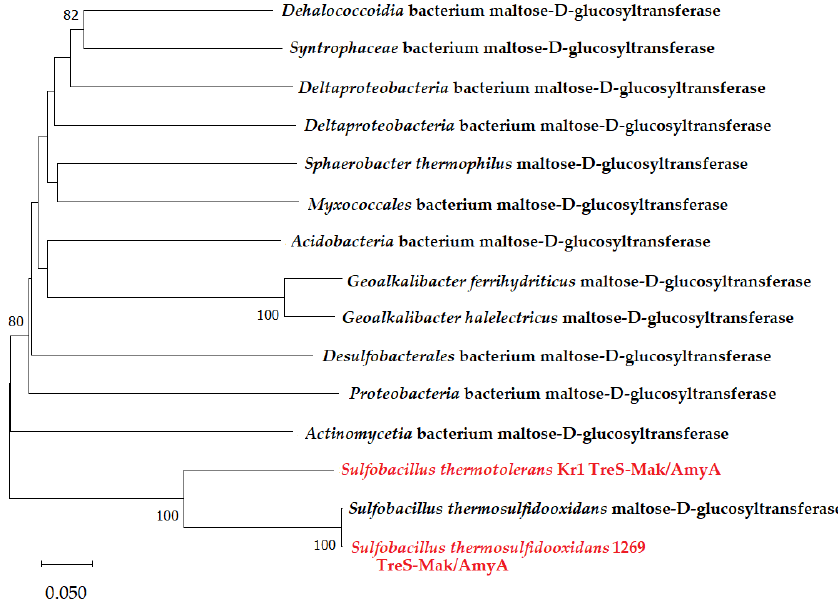
Figure 2. Phylogenetic position of Sulfobacillus α -amylase/trehalose synthase. The phylogenetic tree was constructed using MEGA 11 [35]. The evolutionary history was inferred using the neighbor- joining method [39]. The optimal tree is shown. The percentage of replicate trees in which the associated taxa clustered together in the bootstrap test (1000 replicates) are shown next to the branches (values lower than 80% are hidden) [40]. The tree is drawn to scale, with branch lengths in the same units as those of the evolutionary distances used to infer the phylogenetic tree. The evolutionary distances were computed using the Poisson correction method [41] and are in the units of the number of amino acid substitutions per site. This analysis involved 15 amino acid sequences. All ambiguous positions were removed. There were a total of 1125 positions in the final dataset.